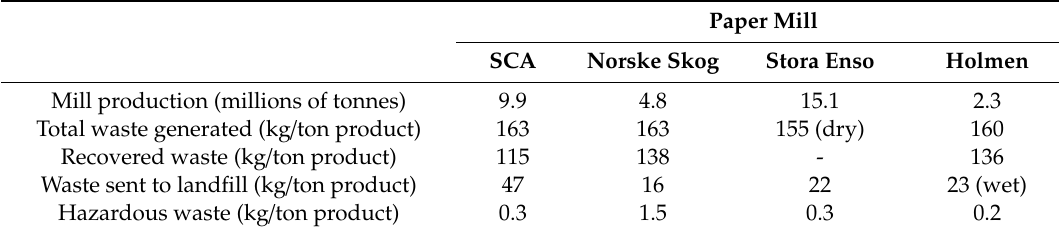
Table 1. Generation of waste from few European pulp and paper mills. Paper Mill SCA Norske Skog Stora Enso